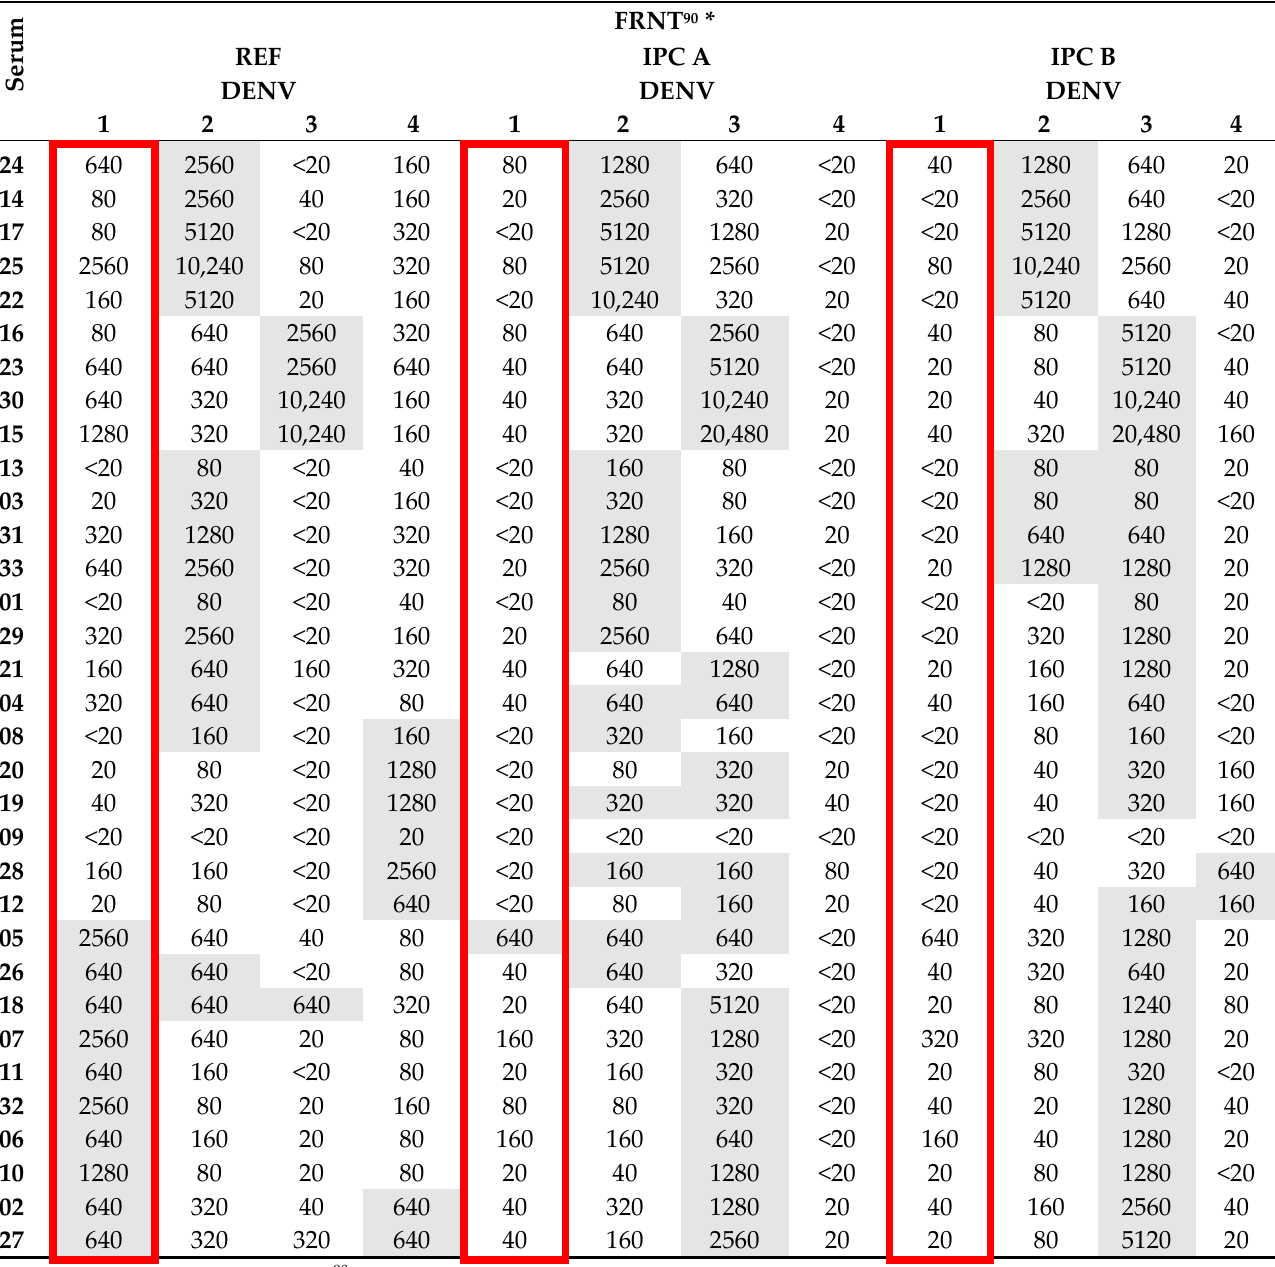
Table 4. Neutralization titers in second sera from DENV-1-infected Cambodian patients.